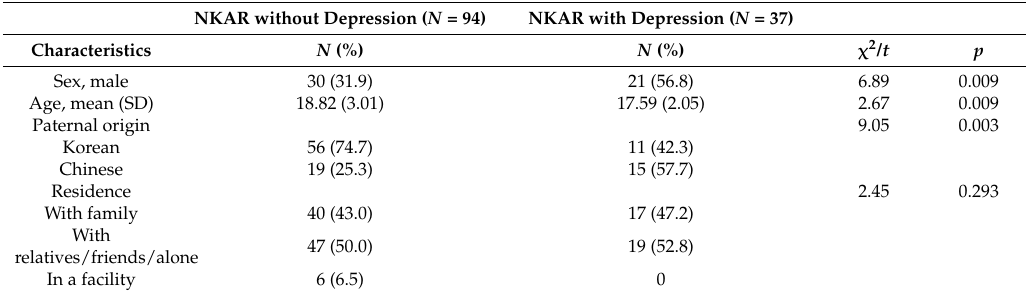
Table 1. Sociodemographic characteristics of North Korean adolescent refugees (NKAR) with and without depression. NKAR without Depression ( N =